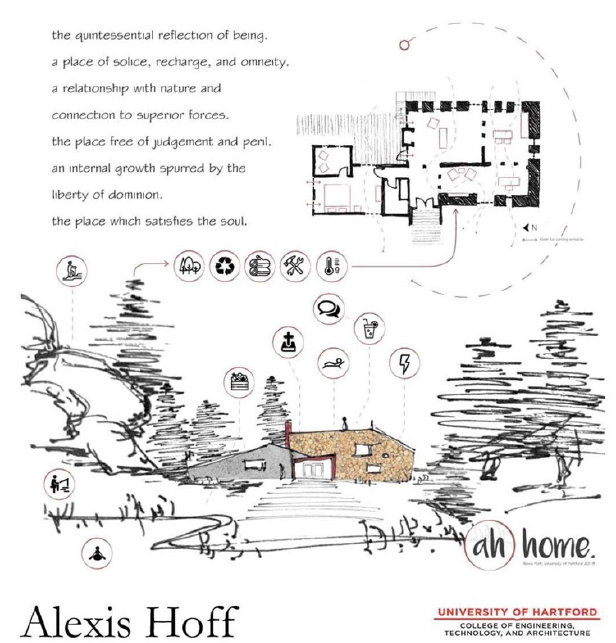
Figure 6. This Spring 2018 entry to Building Beauty’s HOME Competition brings the world into the design, a reversal of the architectural canon.